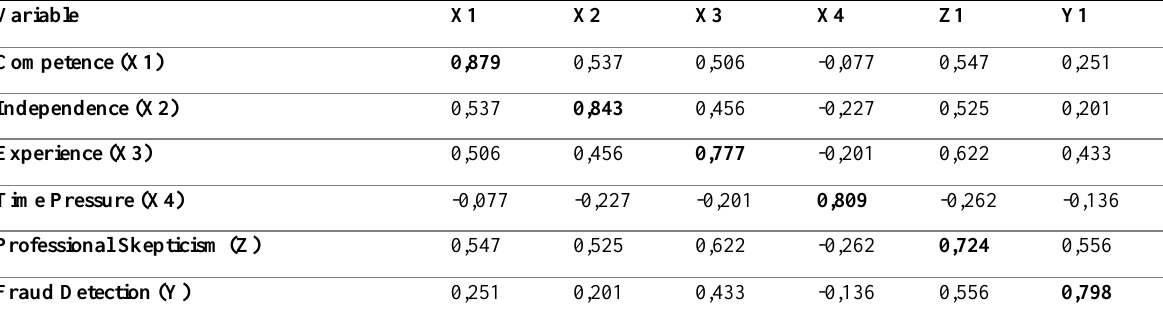
Table 2: Discriminant Validity Test Result